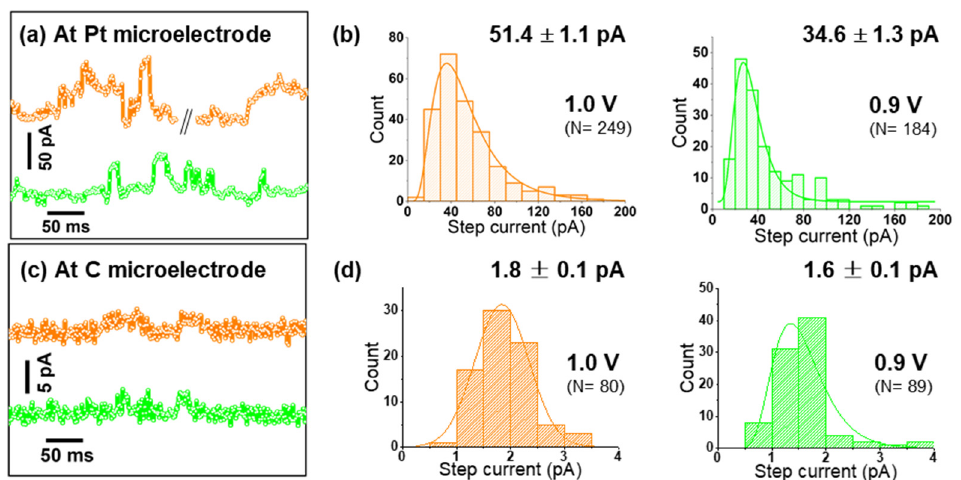
Figure 3. ( a , c ) Representative chronoamperograms (offset for better comparison) pertaining a Pt or carbon microelectrode, respectively; ( b , d ) step-current histograms of Co 3 O 4 nanocubes impacting a Pt or carbon microelectrode at 0.9 and 1.0 V, see Figure 4c,d for data obtained at additional potentials.